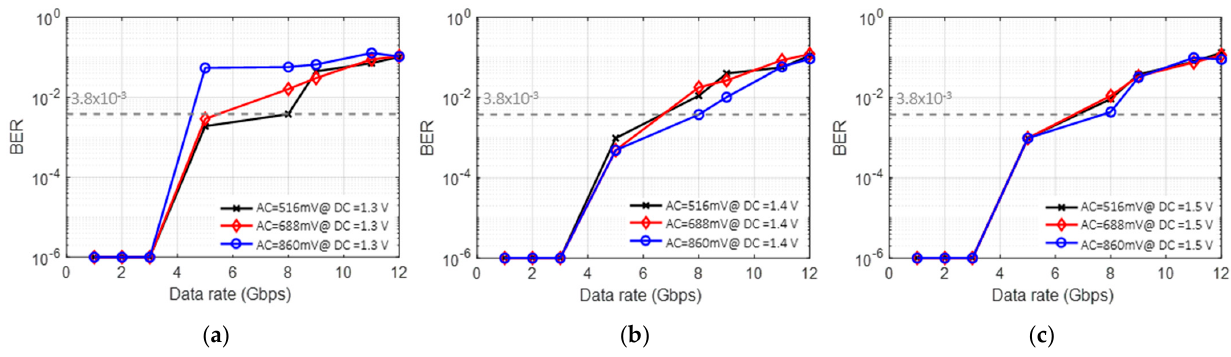
Figure 9. BER performance according to different AC values with a single LSTM network at DC bias of ( a ) 1.3 V, ( b ) 1.4 V, and ( c ) 1.5 V.